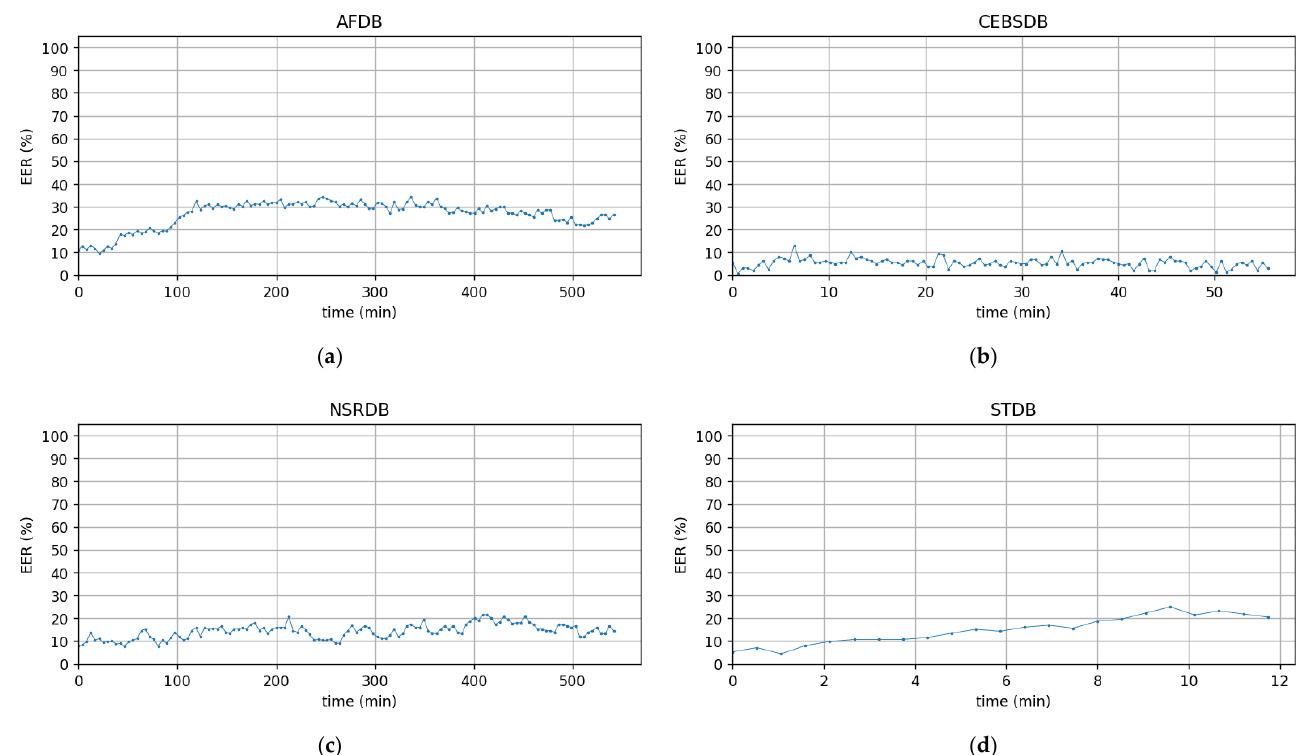
Figure A8. TPR of scope verification is plotted against time separation when FPR is at 10%, 20%, and 30% for: ( a ) AFDB, ( b ) CEBSDB, ( c ) NSRDB, ( d ) STDB.